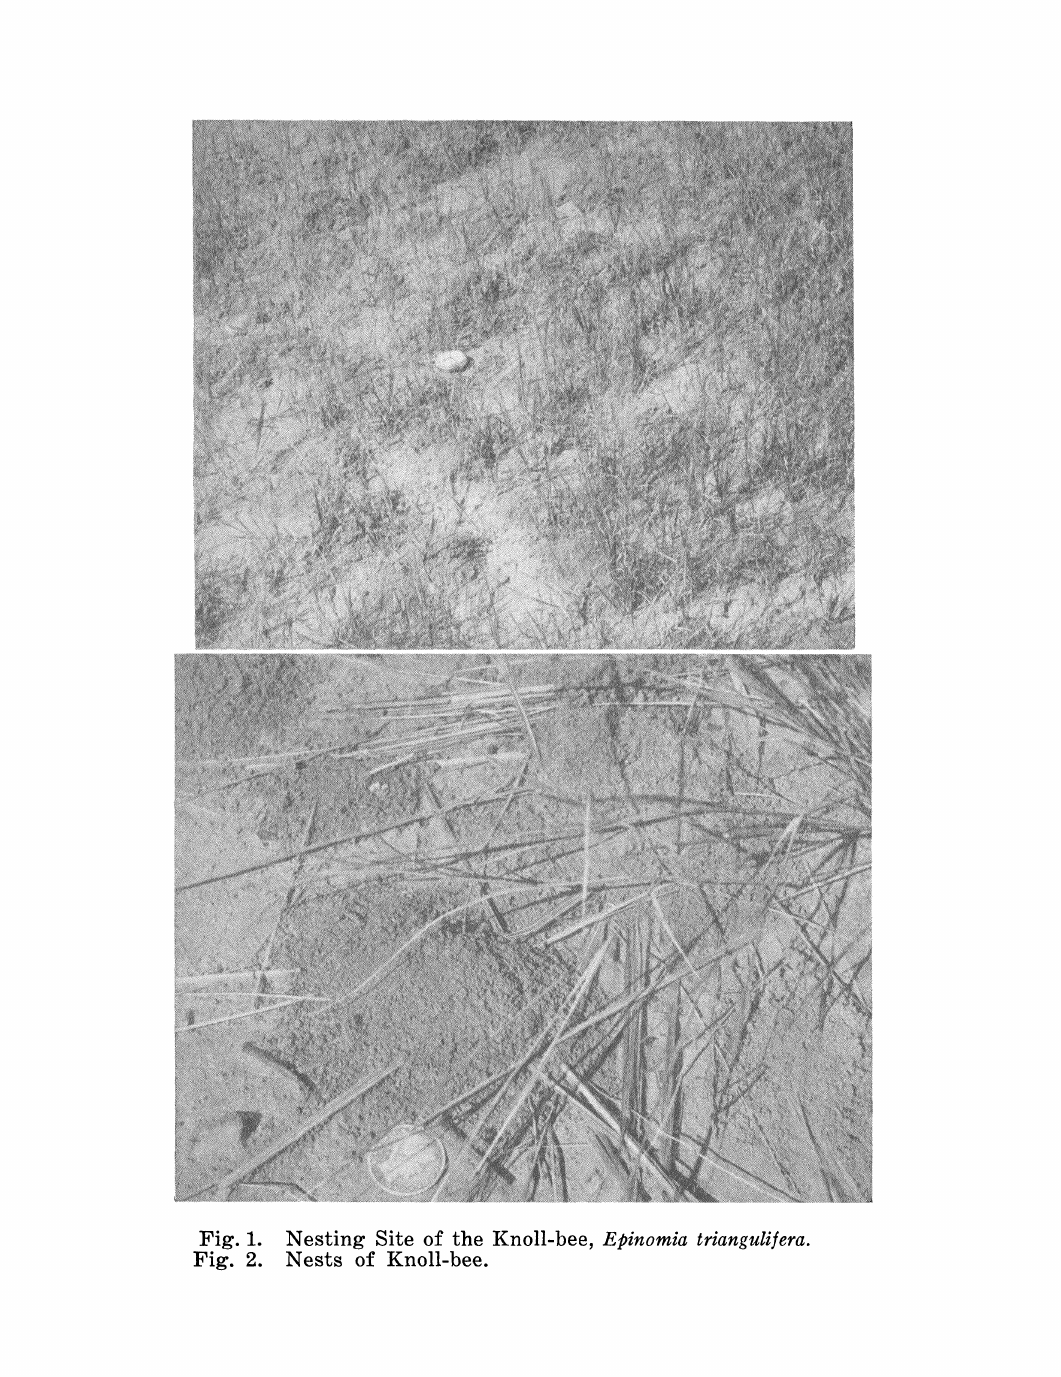
Fig. 1. Nesting Site of the Knoll-bee, Epinomia trianguli]era. Fig. 2. Nests of